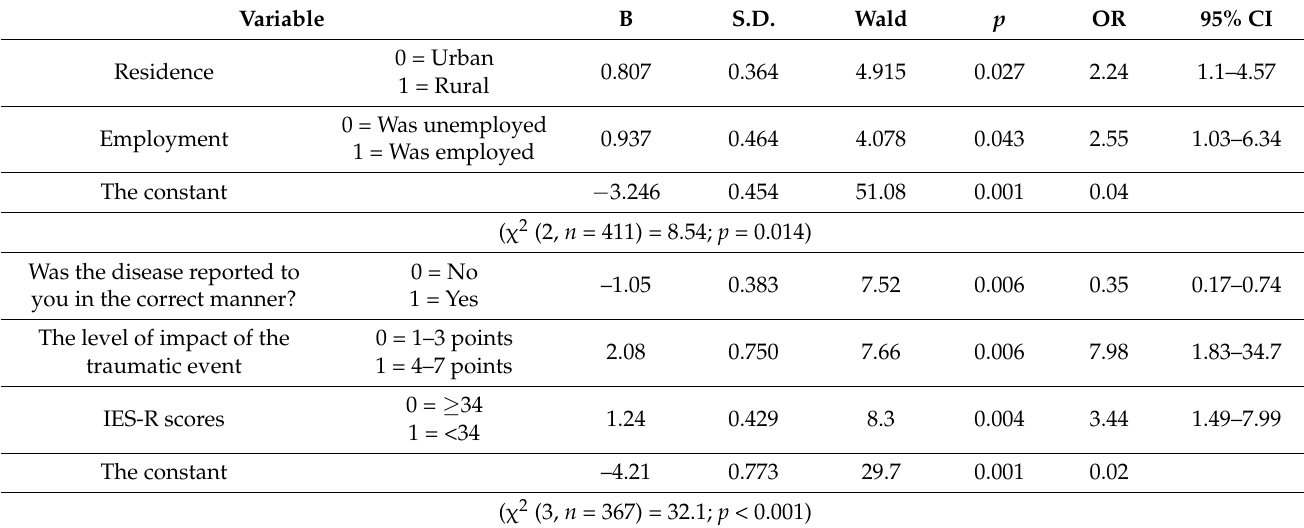
Table 2. Risk factors for suicidal ideation symptoms before the surgery ( n = 421).